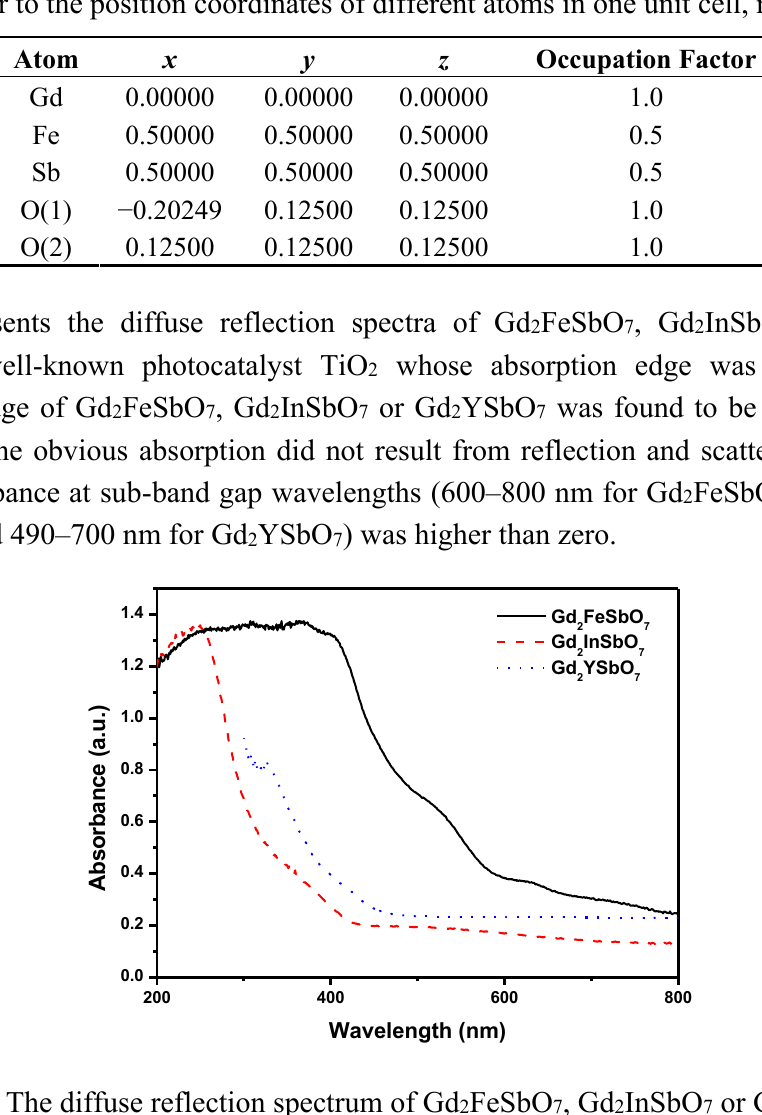
Figure 2. The diffuse reflection spectrum of Gd 2 FeSbO 7 , Gd 2 InSbO 7 or Gd 2 YSbO 7